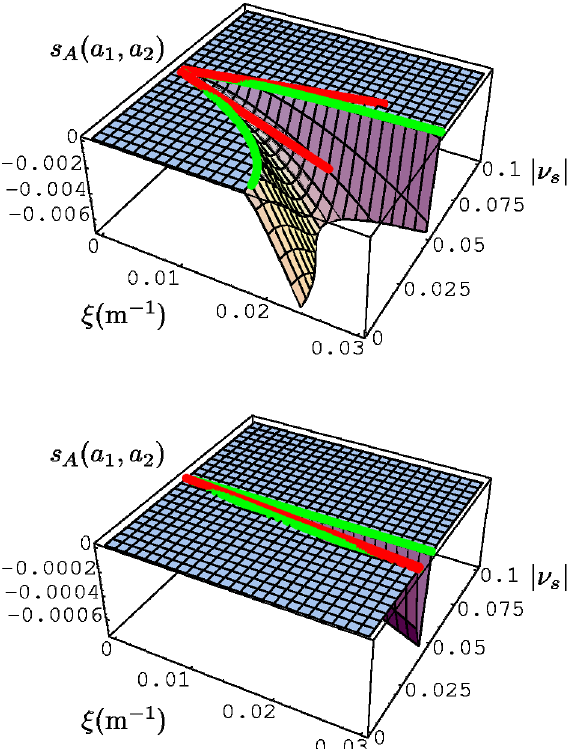
FIG. 2. (Color) Unstable region caused by a crab cavity. Light green: border of stability; dark red: approximation in Eq. (25) to this border.